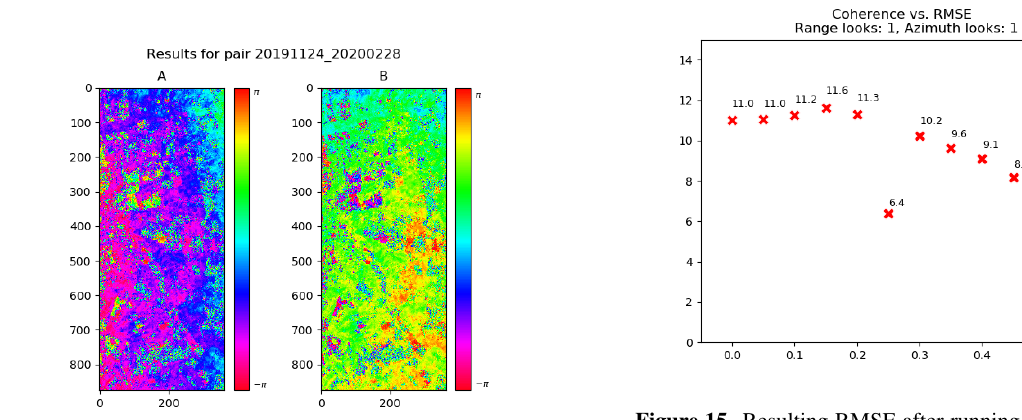
Figure 15. Resulting RMSE after running the orbital correction with different coherence thresholds (Pair #2, HH polarimetric